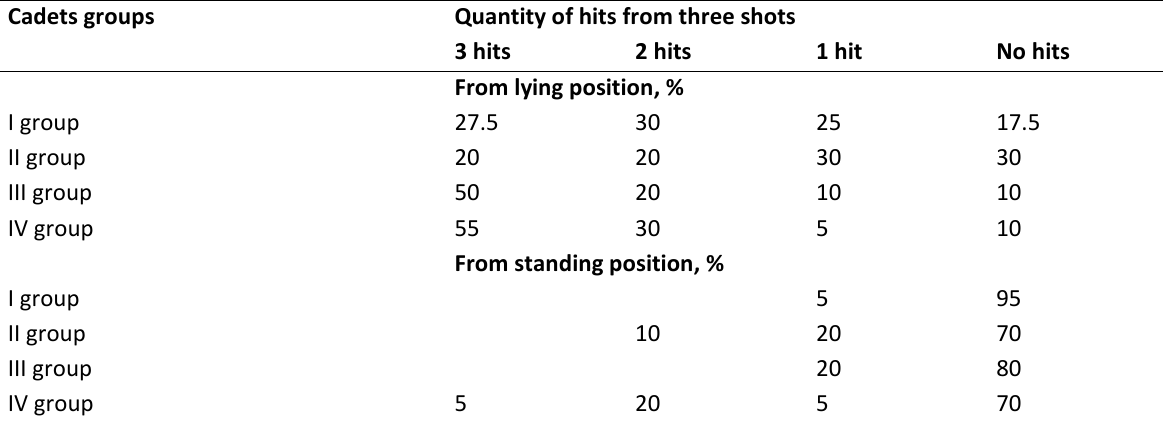
Table 1. Results of shooting at target No.4 (human height) from different positions, % Cadets